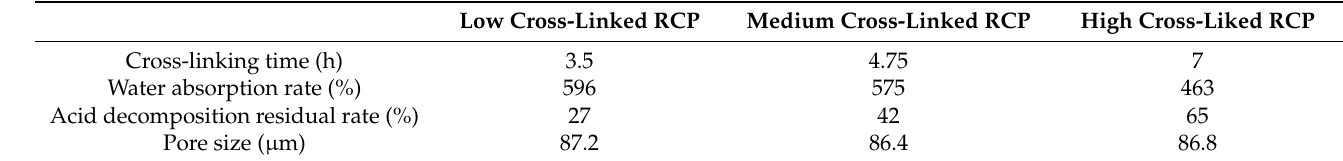
Table 1. Characteristics and pore size of three types of cross-linked RCP particles. Low Cross-Linked